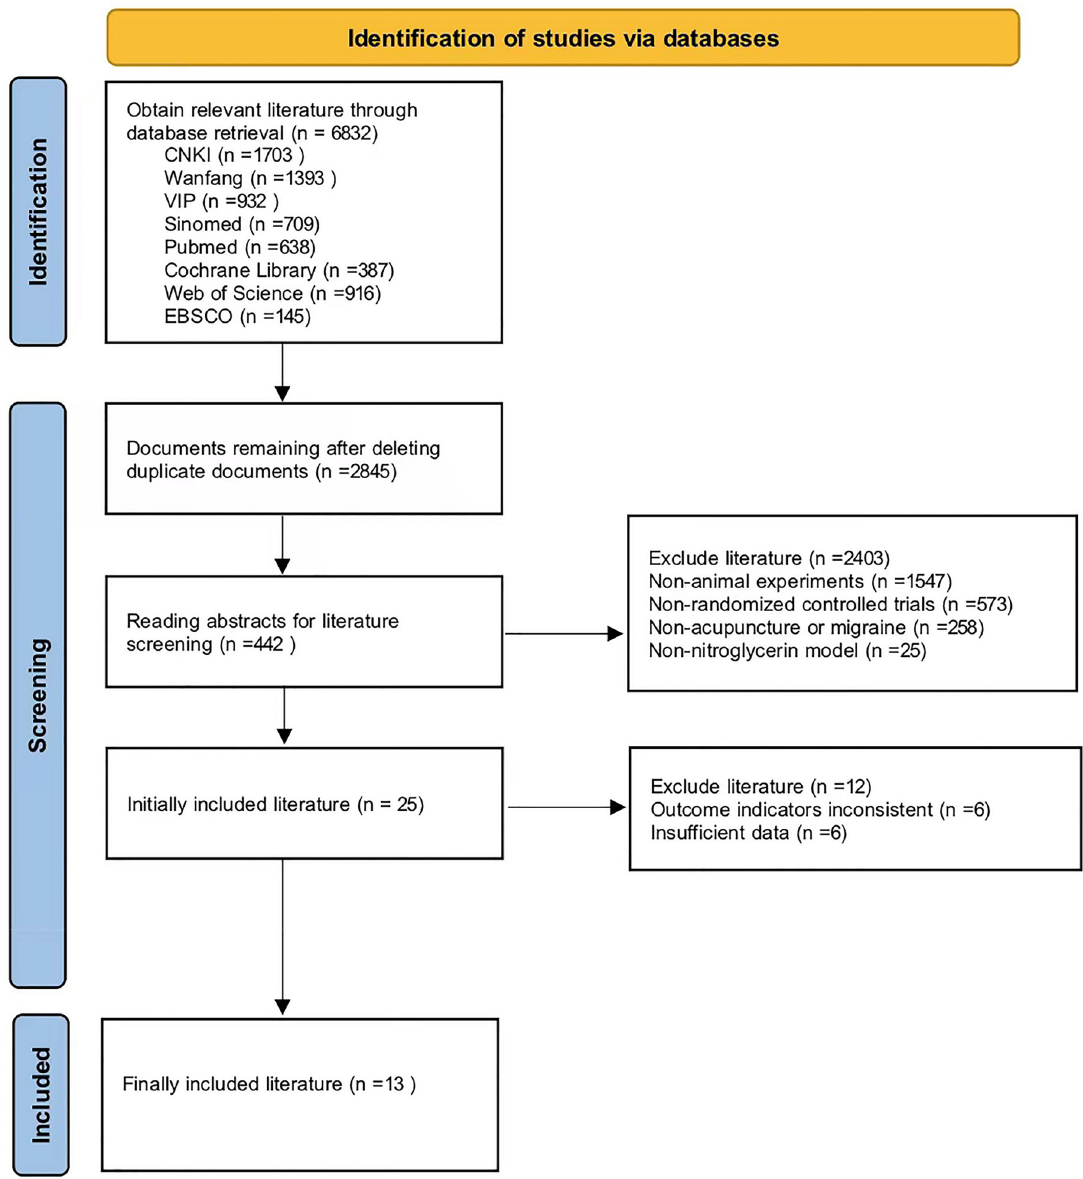
Fig 1. Flow diagram of literature